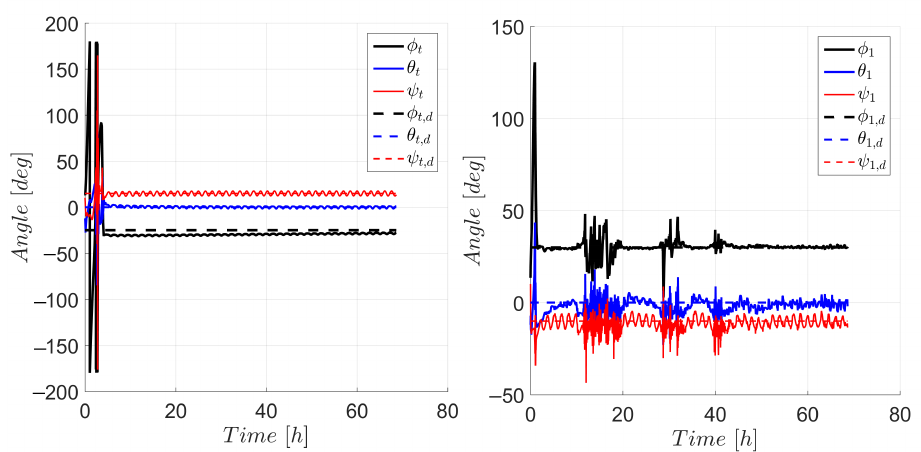
Figure 8. Attitude of the target ( left ) and chaser ( right ) spacecraft expressed in Euler angle representation.